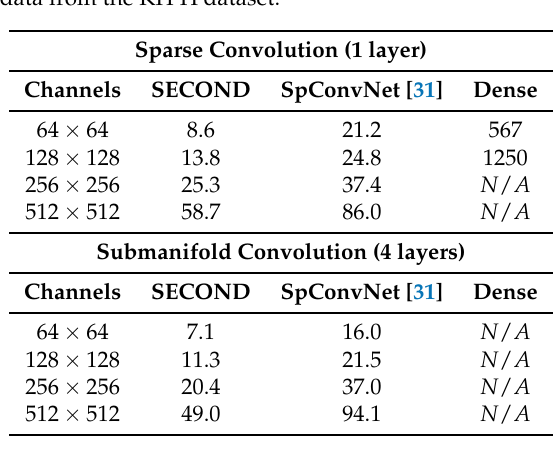
Table 1. Comparison of the execution speeds of various convolution implementations. SparseConvNet is the official implementation of submanifold convolution [27]. All benchmarks were run on a GTX 1080 Ti GPU with the data from the KITTI dataset.